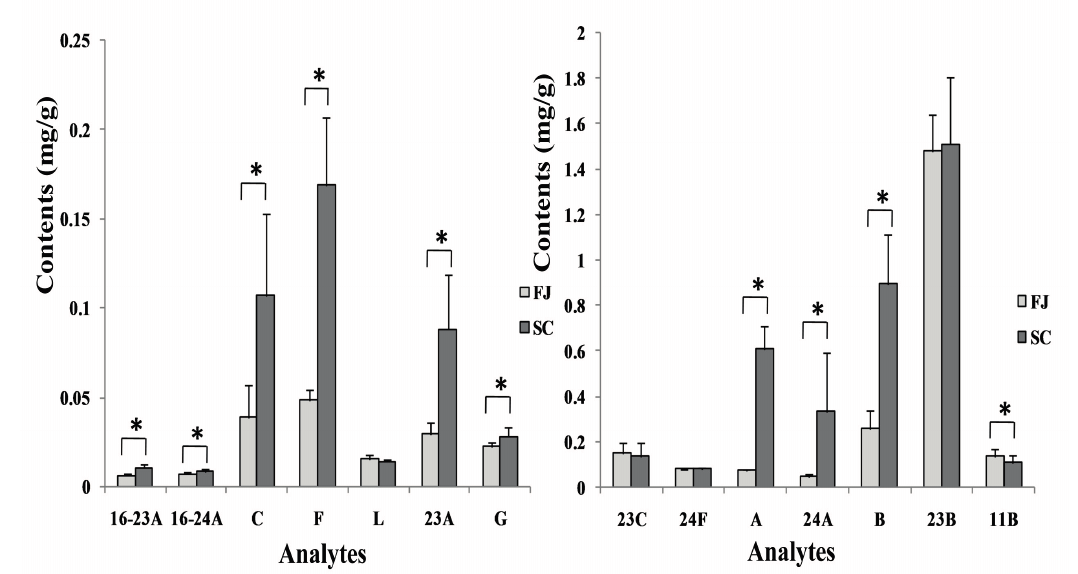
Figure 5. Contents (mg/g) of the fourteen triterpenoids in AMR. 16-23A: 16-oxo-alisol A 23-acetate, 16-24A: 16-oxo-alisol A 24-acetate, C: alisol C, F: alisol F, 23C: alisol C 23-acetate, L: alisol L, 24F: alisol F 24-acetate, A: alisol A, 23A: alisol A 23-acetate, 24A: alisol A 24-acetate, G: alisol G, B: alisol B, 23B: alisol B 23-acetate, 11B: 11-deoxy-alisol B. FJ: Fujian Samples, SC: Sichuan Samples, Student’s t -test was used for the statistical analysis. * p <